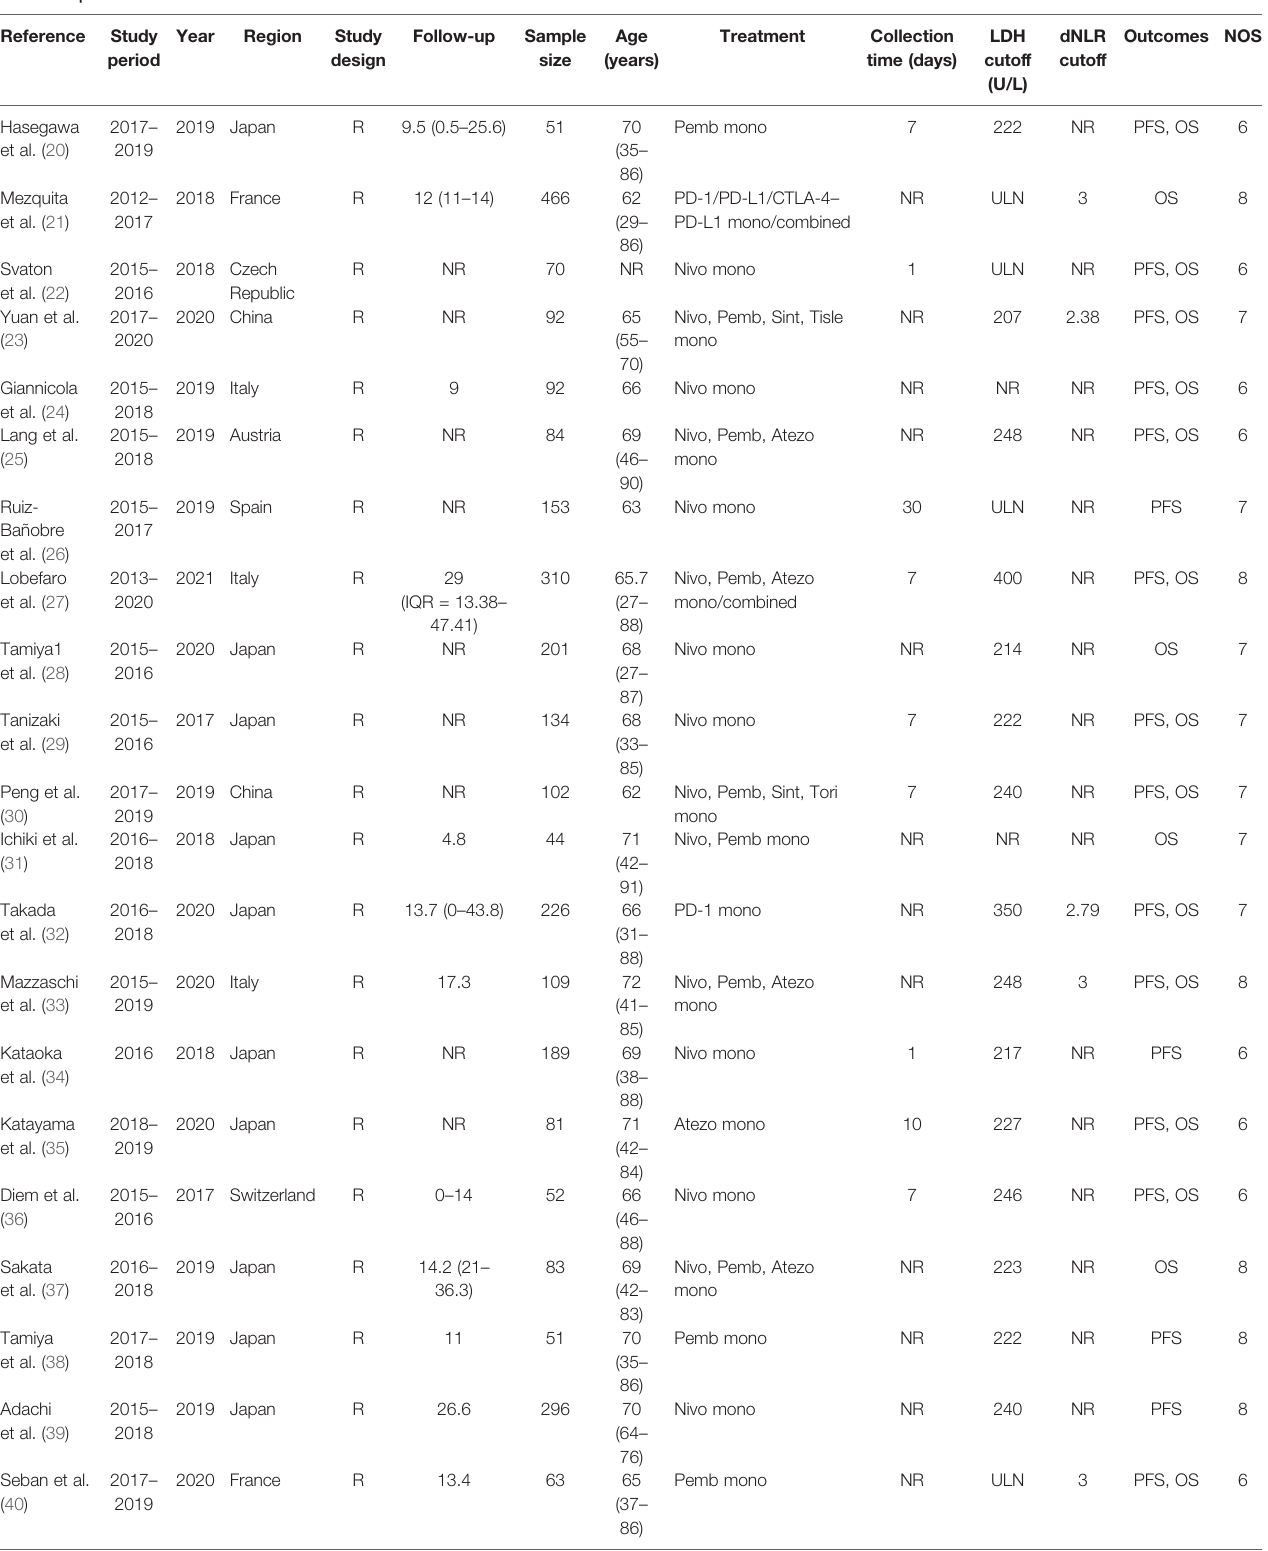
TABLE 1 | Characteristics of the included